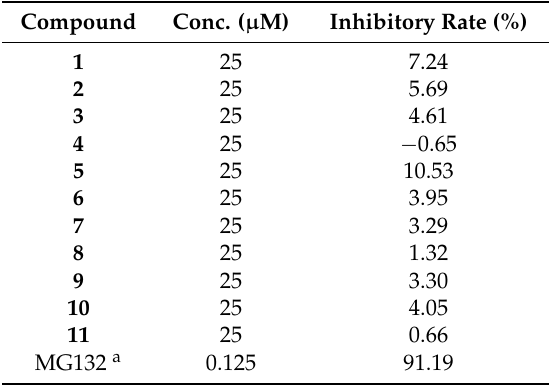
Table 3. Inhibitory effects of compounds 1 – 11 on NO